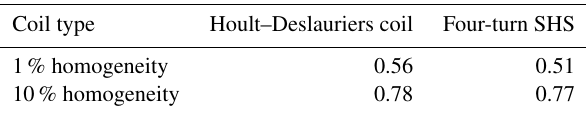
Table 3. Four-turn axisymmetric coil homogeneity: comparison be- tween the Hoult–Deslauriers coil and the four-turn SHS